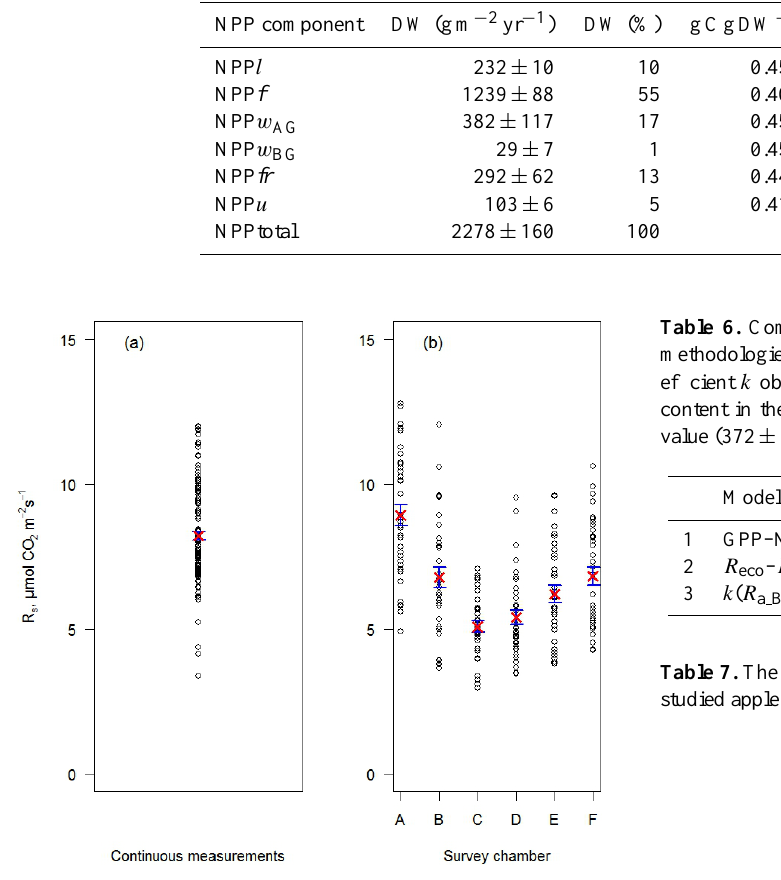
Fig. 3. Comparison of R s data (µmolCO 2 m 2 s − 1 ) obtained from the multiplexed system (a) with those obtained from the survey chamber (b) . Crosses indicate the average value; blue bars indicate the standard error. All the measurements were taken along the tree- line in the same time period (24–30 June 2010), to account for the variability within the orchard treelines. Letters (A to F) represent the six plots of the survey campaign.